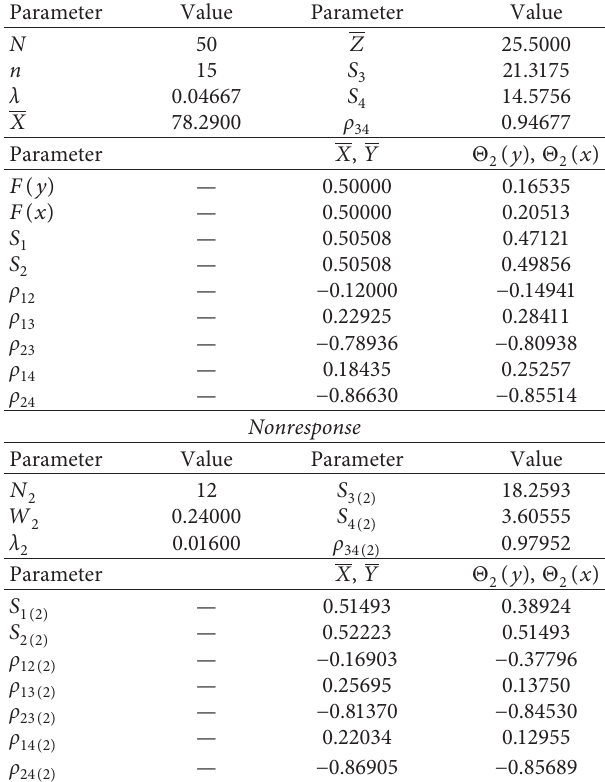
Table 5: Summary statistics for population